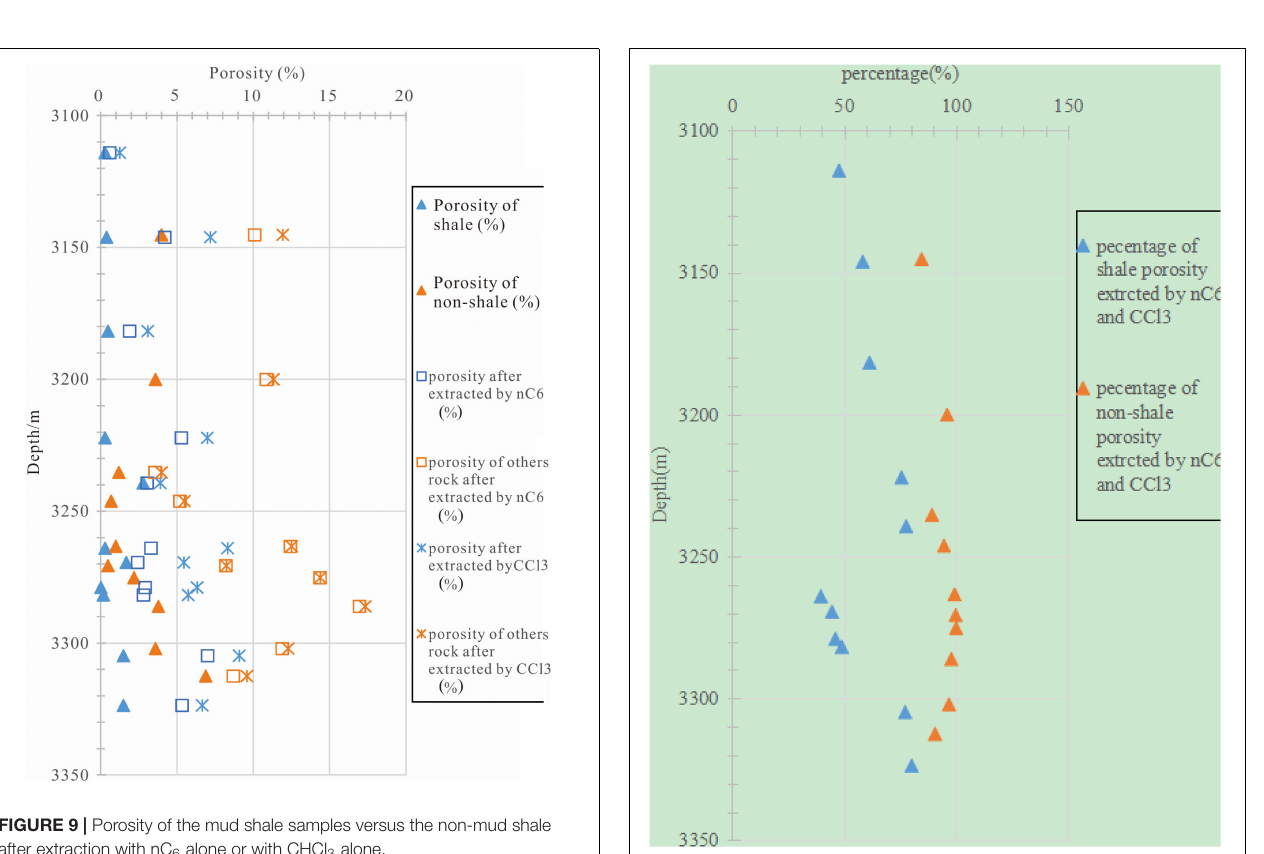
FIGURE 8 | Relationship between the content of the asphaltene and the viscosity (20 ◦ C) for crude oil extracted from the Jimsar Sag (the crude oil data were provided by the Xinjiang Oilfield Company of CNPC).